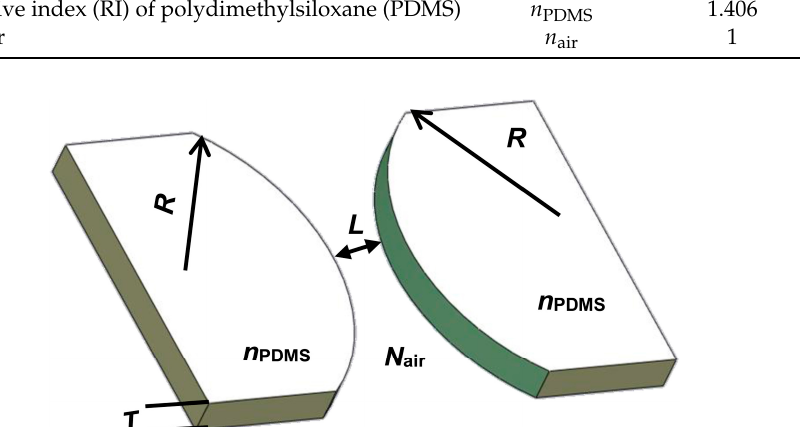
Figure 2. Device structure design of the collimating unit.